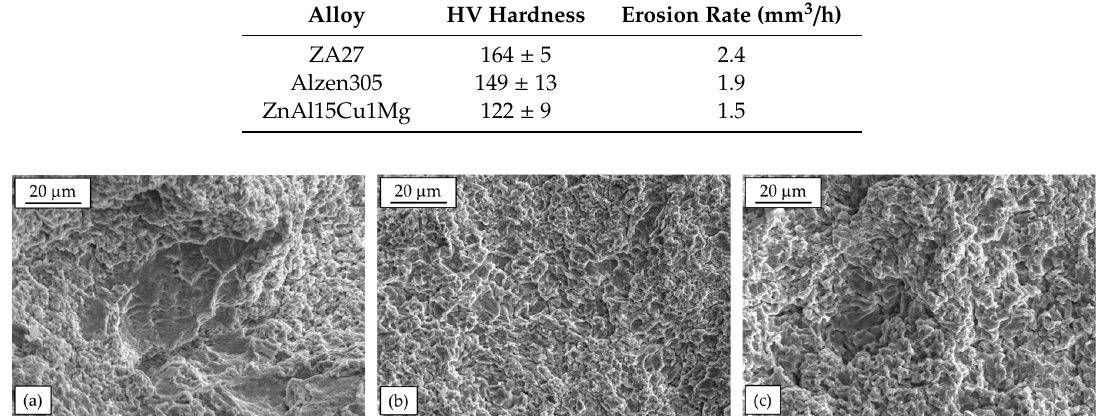
Figure 8. SEM analyses of the eroded surfaces after 8 hours for ( a ) ZA27, ( b ) ZnAl15Cu1Mg, and ( c ) Alzen305.